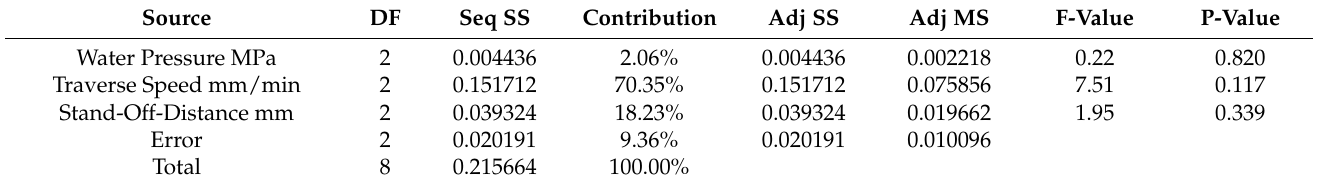
Table 24. ANOVA table for kerf taper angle response of input cutting parameters of 6 mm thickness of SPF-UPE composite cut with abrasive water jet technique.